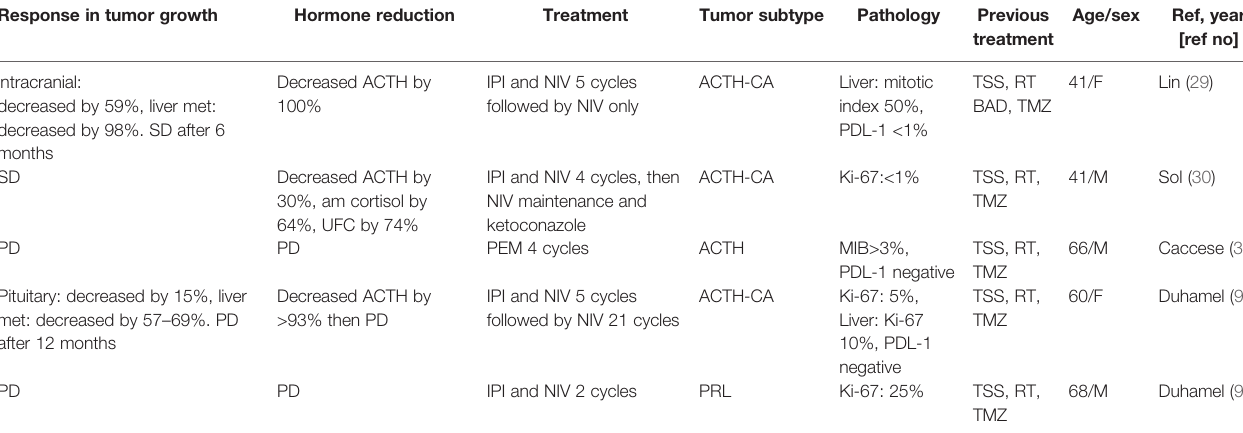
TABLE 5 | Published cases of Immunotherapy treatments for pituitary tumors and